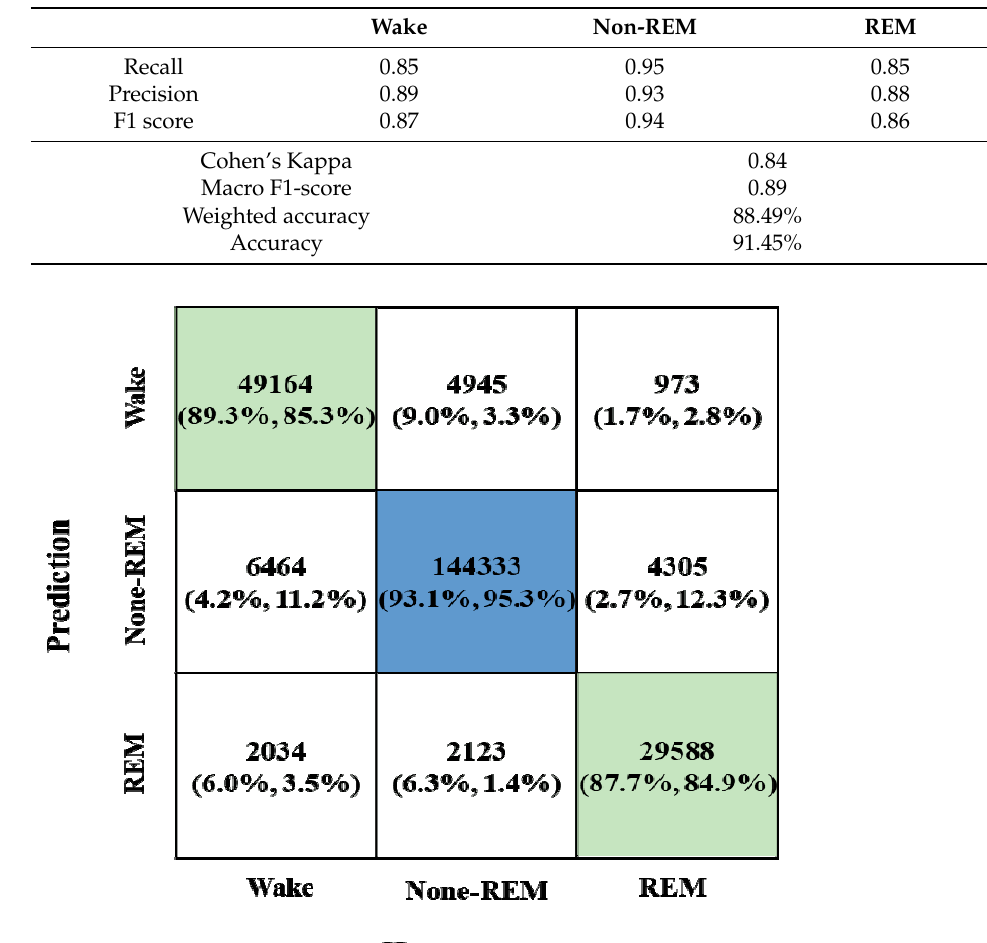
Figure 5. Classification performance of the deep learning model for sleep stage scoring. Confusion matrix showing numbers of samples classified correctly or incorrectly as a percentage: precision and recall values for each case.